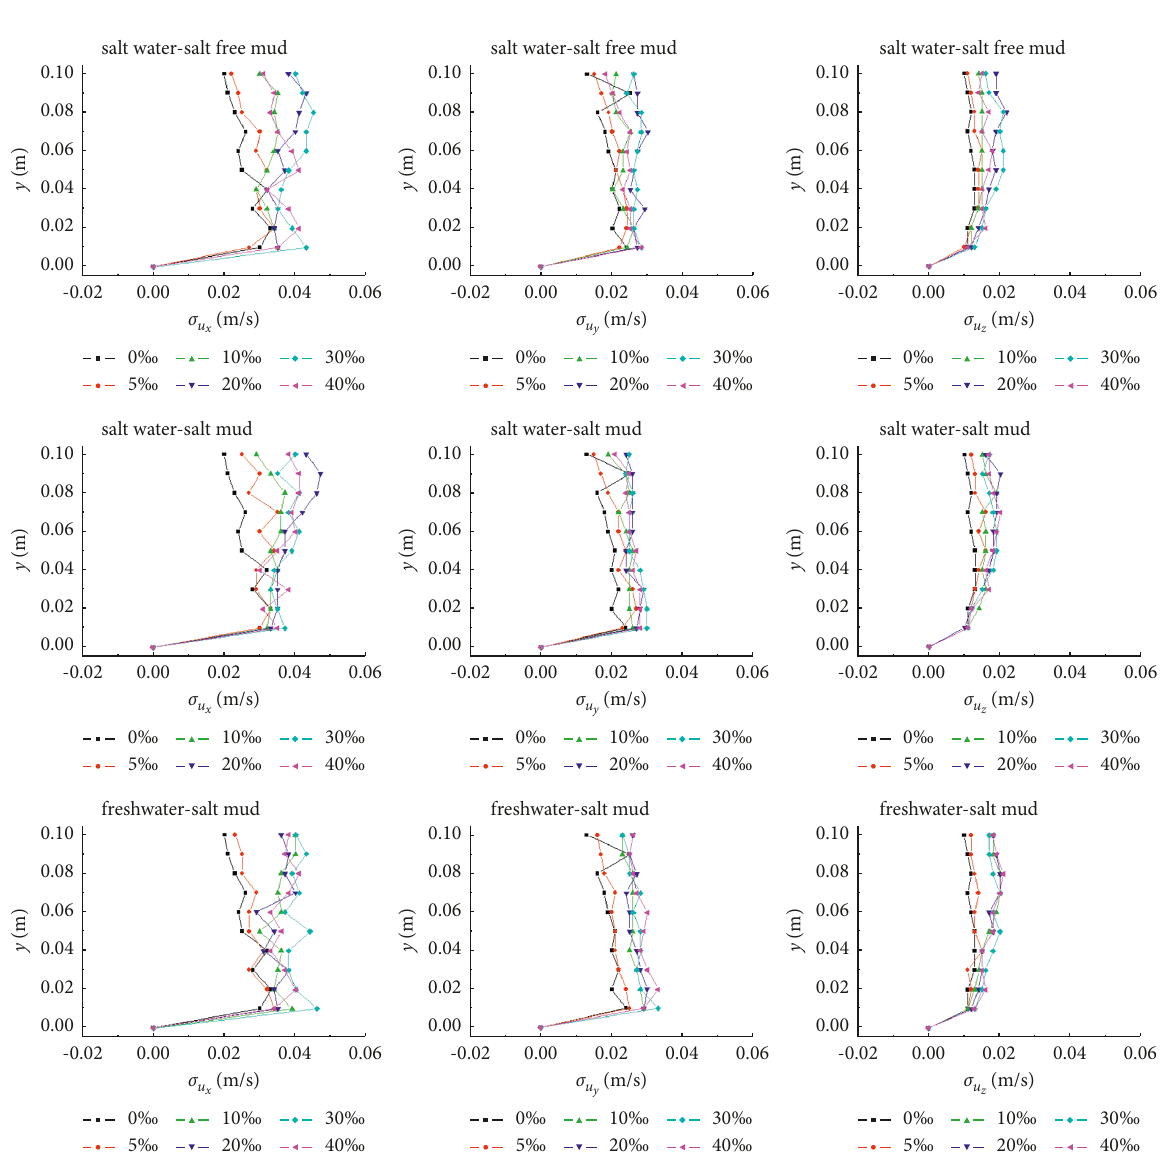
Figure 8: Turbulence intensity of flow under critical condition of the muddy clay onset.